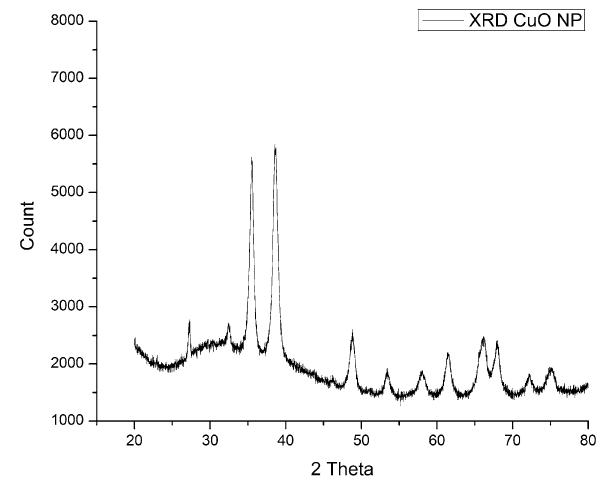
Fig. 2 XRD of CuO NP after